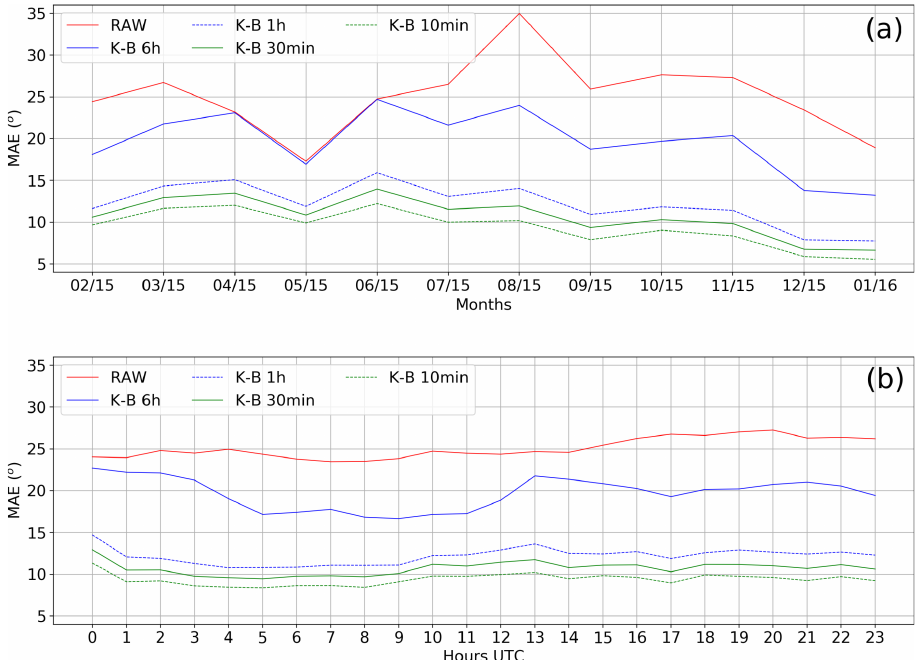
Figure 8. ( a ) Monthly wind direction MAE for the wind farm with K-B model experiments and RAW. ( b ) Wind direction MAE, hourly (moving average) for the entire 24 h simulation period. In both cases the comparison is between RAW outputs (red) and K-B model cases: K-B 6 h (blue), K-B 1 h (dotted blue), K-B 30 min (green) and K-B 10 min (dotted